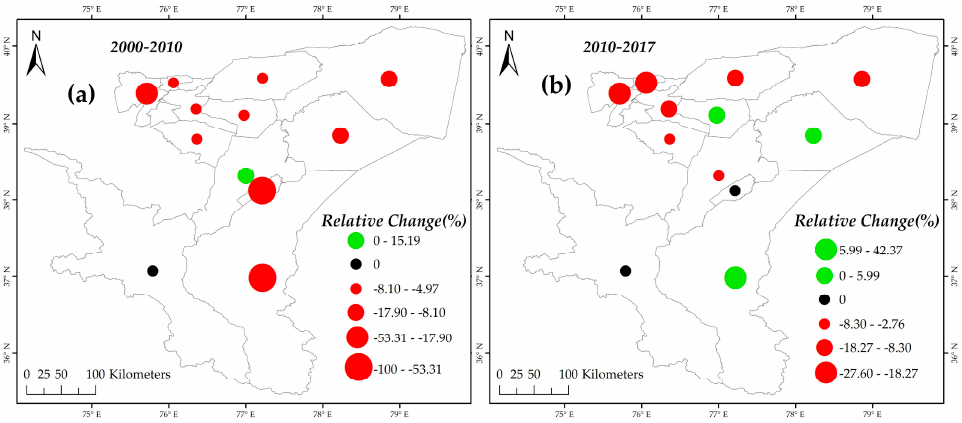
Figure 6. Relative change rate of soil salinization severity in different counties of the Kashgar region during 2000 to 2010 ( a ) and 2010 to 2017 ( b ).